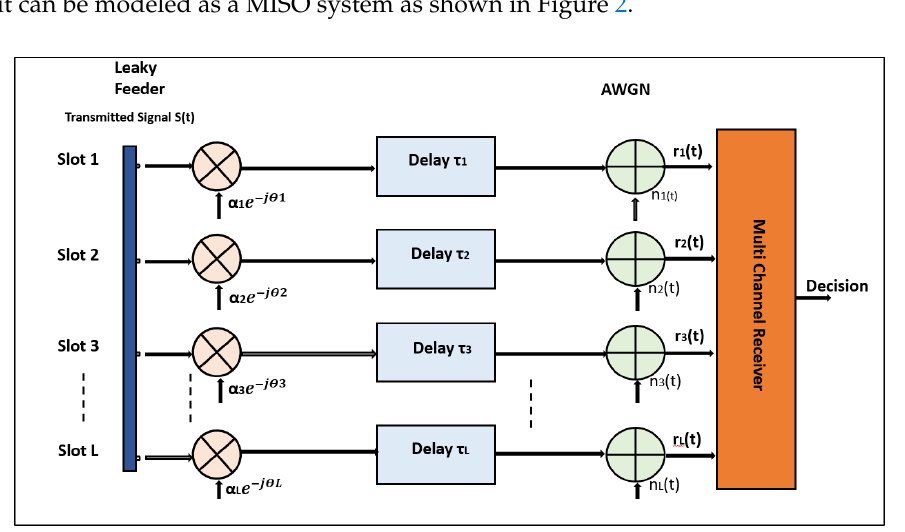
Figure 2. Leaky feeder channel